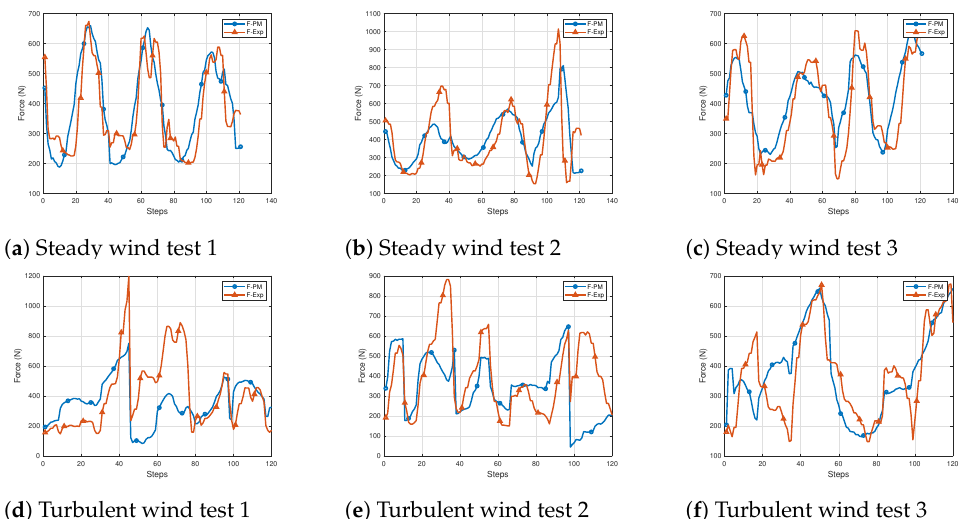
Figure 18. Validation of the physical model with the experimental data: ( a – c ) steady wind conditions, ( d – f ) turbulent wind